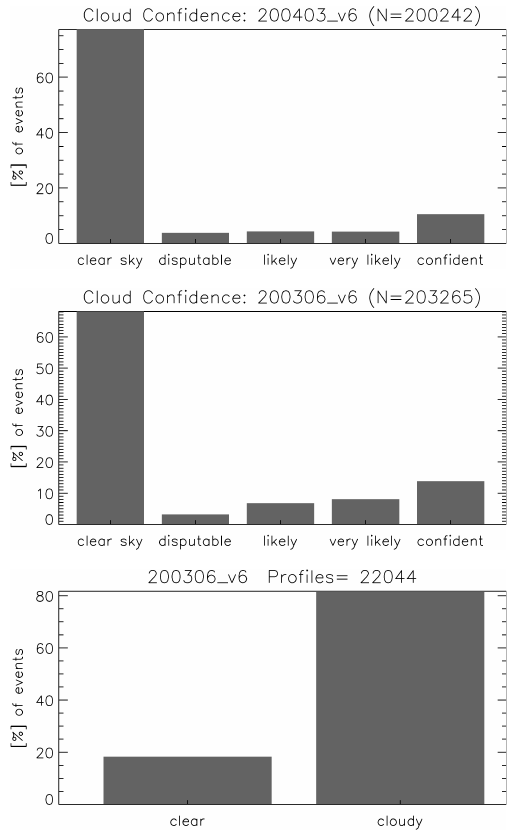
Fig. 4. Probability distribution in percentage of the normalised cloud confidence classes (for definition s , Table 3) for all spectra analysed for March 2004 (top) and June 2003 (middle) in the alti- tude range 3 to 33km. The bottom figure shows the corresponding number of cloudy and non-cloudy profiles for the June 2003 distri- bution shown